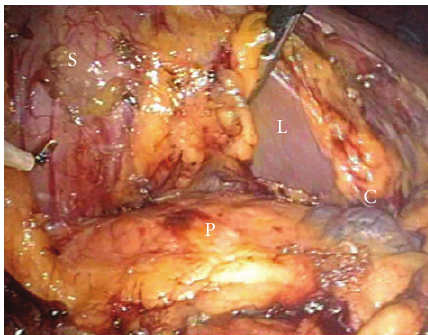
Figure 3: Exposure of pancreas. The lesion is seen at the right side of the picture. (C = cyst, P = pancreas, L =